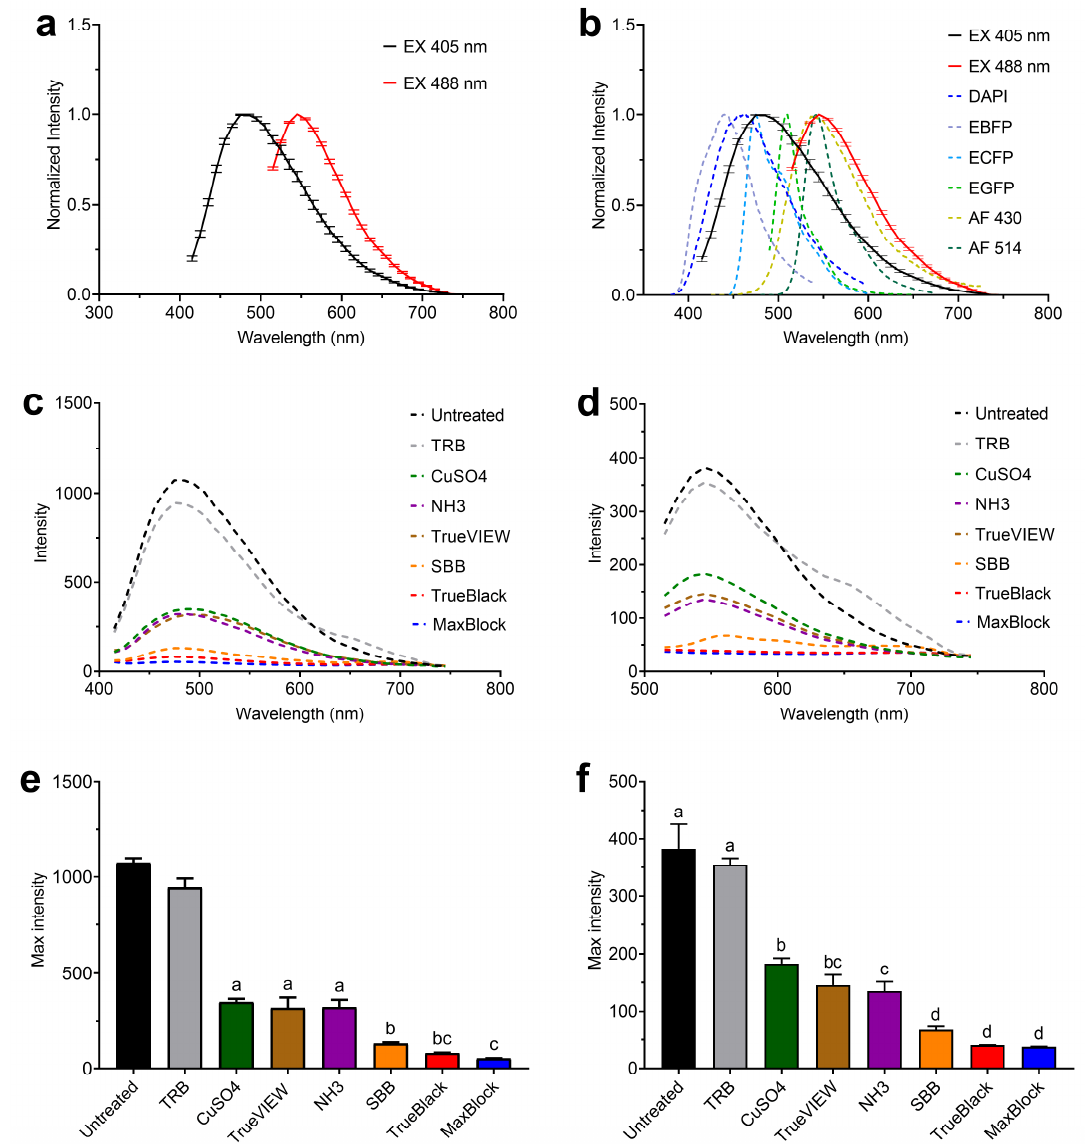
Figure 1. Autofluorescence (AF) emission of untreated PFA-fixed mouse adrenal cortex tissue sections and sections treated with AF reduction methods. Emission line graph of normalized AF emission from untreated adrenal cortex at 405 nm and 488 nm excitation wavelengths ( a ). The interference of adrenal cortex AF spectrum with the spectra of commonly used fluorescent proteins and dyes ( b ). AF emission intensity of untreated adrenal cortex and tissue section treated with AF reduction methods at 405 nm excitation ( c ) and 488 nm excitation ( d ). The means of maximum AF intensity from untreated and treated adrenal cortex sections at 405 nm excitation ( e ) and 488 nm excitation ( f ). ANOVA results are indicated by letters in column superscript. Treatments sharing one letter are not significantly different. Treatments not sharing a letter are significantly different ( p < 0.05). Bars denote the SD.